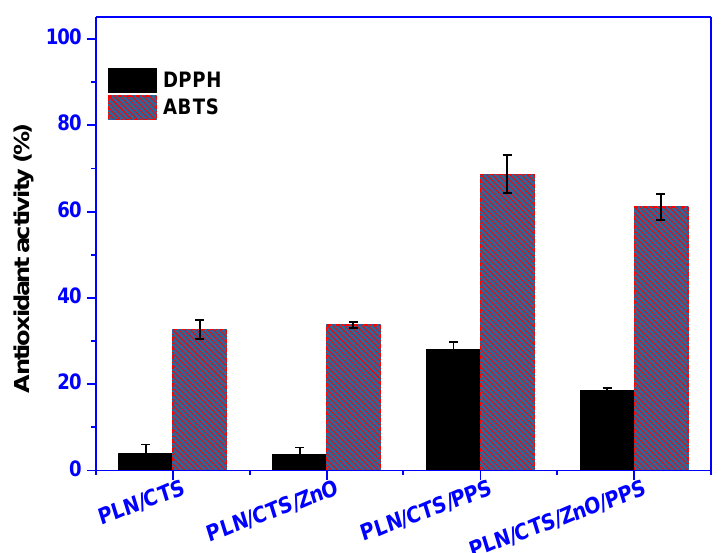
Figure 6. Antioxidant activity of pullulan/chitosan-based composite films.